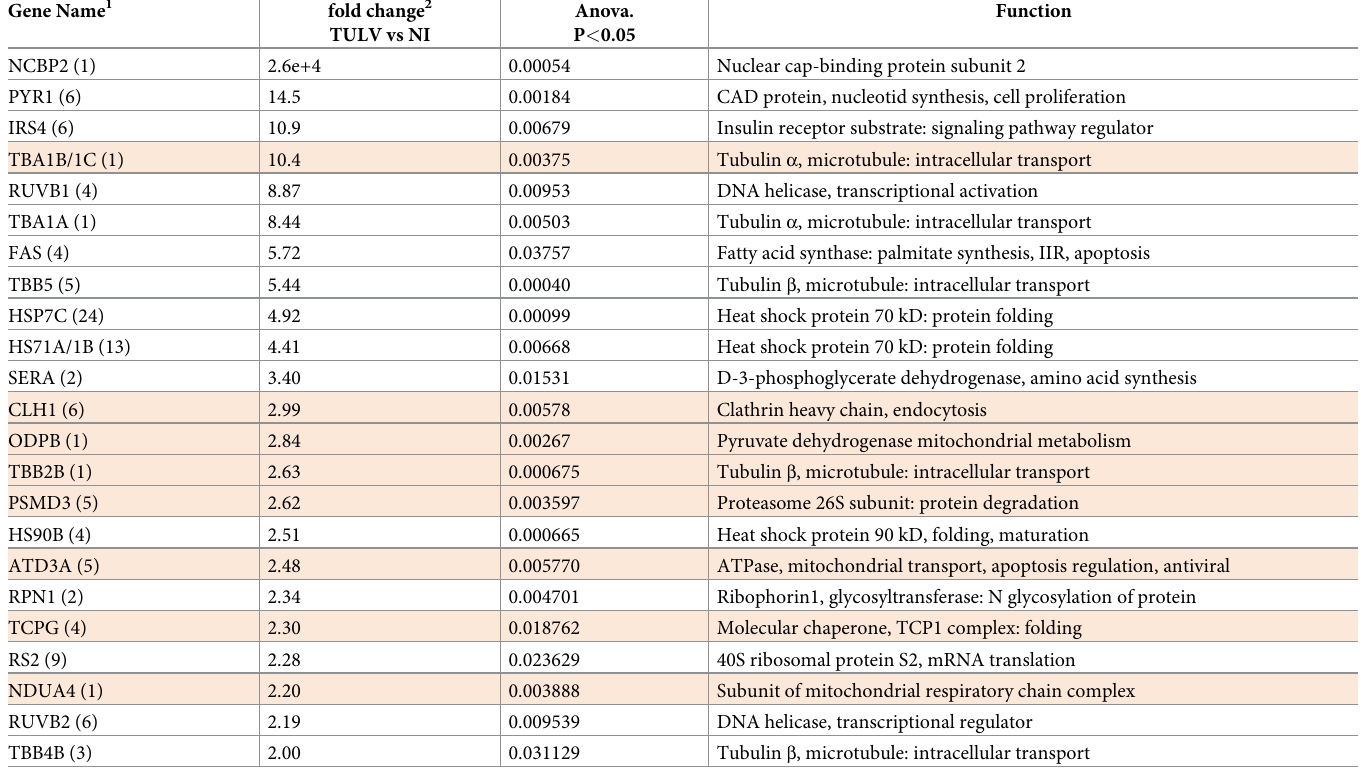
Table 3. Human proteins found in complex with TULV-N in HEK293T